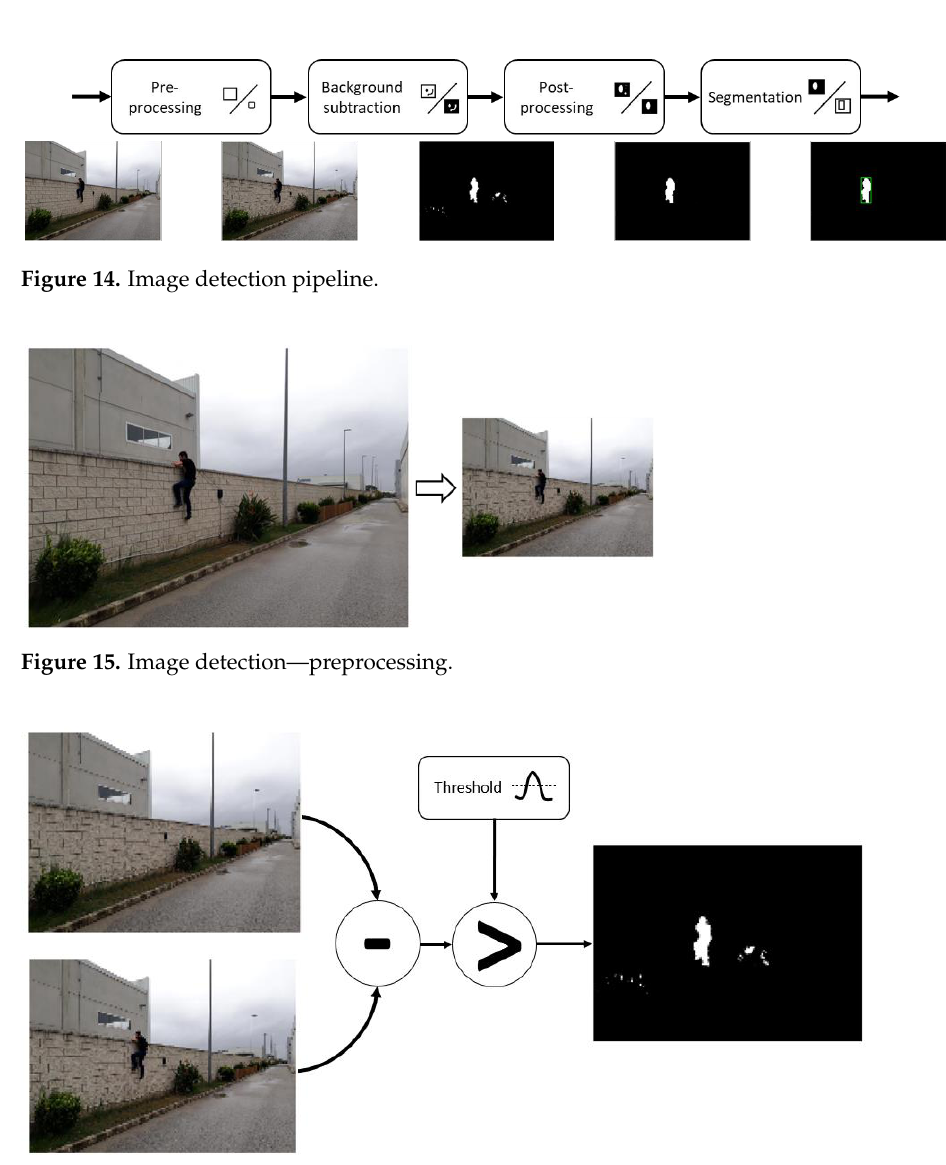
Figure 16. Image detection—background subtraction.